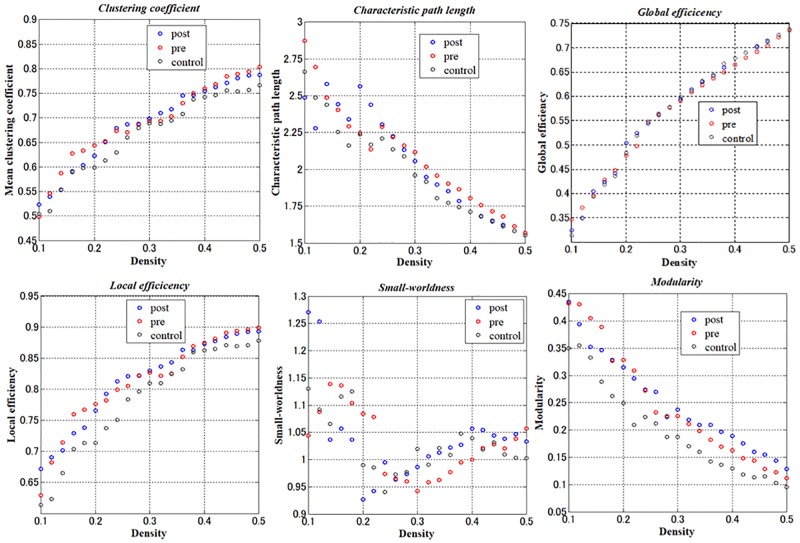
Results of AUC comparisons in each network metrics among the three groups.The meanings of the measures are described in the Materials and Methods section of the text. Each point is the mean value of global network metrics for the pre-CC, post-CC, and control groups across the range of density thresholds from 0.1 to 0.5 used to binarize the adjacency matrix. There was no relationship in global graph metrics among the three groups. AUC, area under the curve.